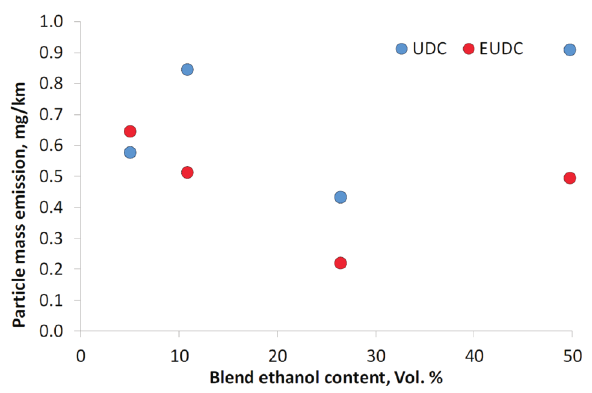
Fig. 9. Vehicle PM emissions on UDC and EUDC cycle [9]